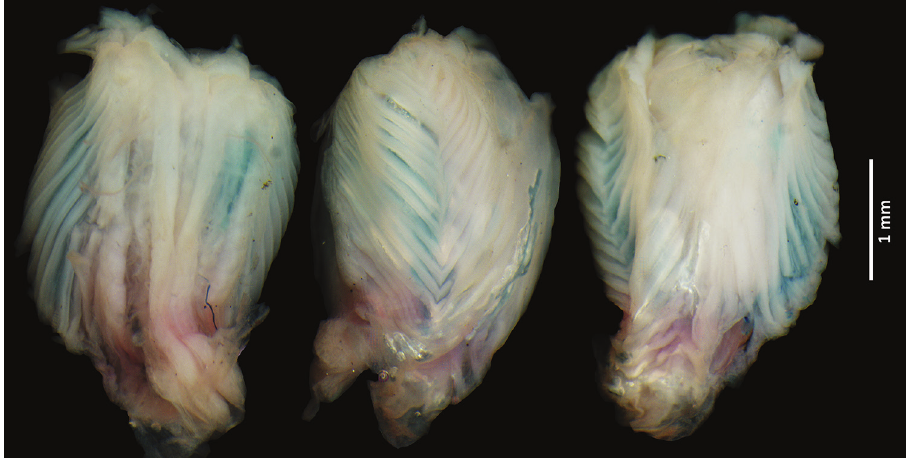
Figure 3. Oreosaurus serranus sp. n. Sulcate (left), lateral (center) and asulcate (right) views of the right hemipenis of ROM 53610